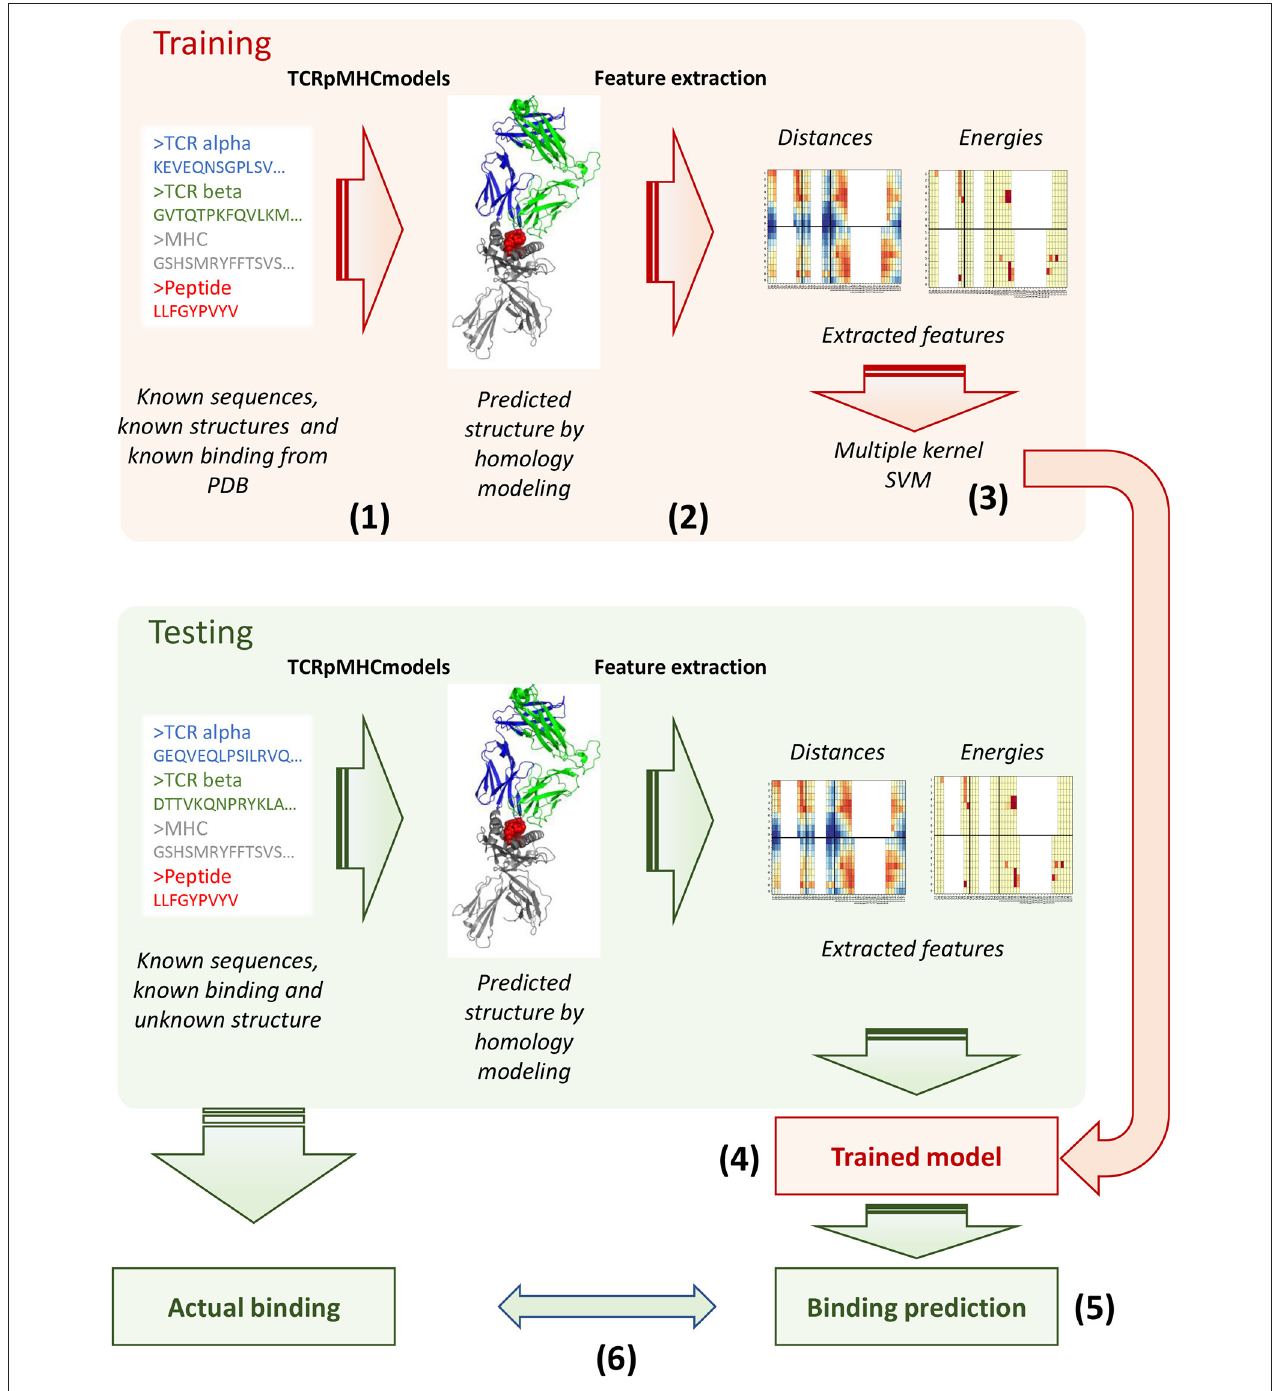
FIGURE 3 | Schematics of the modelling and prediction approach. For each sequence in the training set (the STCRDab set), a predicted structure was generated using TCRpMHCmodels (step 1) and features extracted using the pipeline described in the methods (step 2, the features extracted from the original and the predicted structures are compared to the original crystal structures in Figure 4 and Supplementary Figure 3 ). The feature extracted were combined in multiple kernels (step 3) and multiple predictive models were generated which could distinguish binding and non-binding pairs (step 4). The model performance upon cross-validation is evaluated in Figure 6 . The same structure prediction and feature extraction pipeline was applied to multiple test sets, for which binding is known but structure is not. The model generated in step 4 was used to make a prediction of binding for these new sequences (step 5), and the results were compared against the actual binding information to get an estimate of performance (step